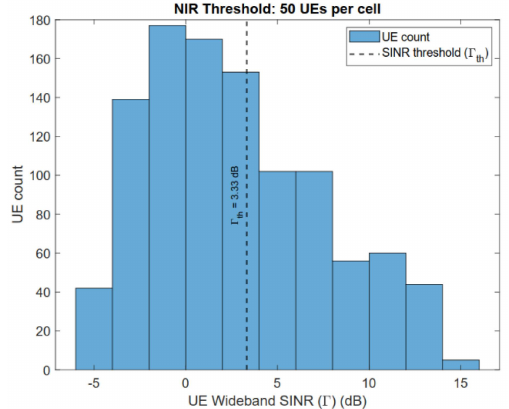
Figure 6. Wideband SINR distribution for 50 UEs.